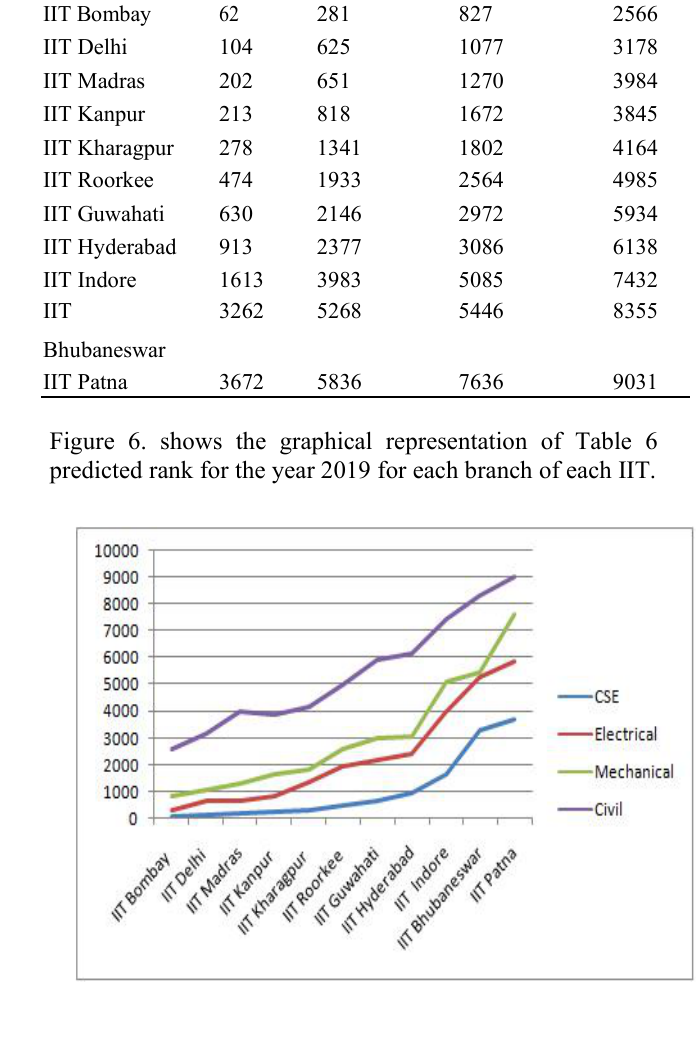
CSE branch of IIT Bombay (Output Data) CSE-IIT Bombay